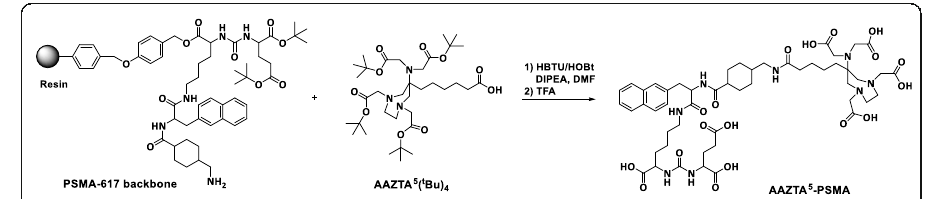
Fig. 2 Reaction of AAZTA 5 ( t Bu 4 ) with PSMA-617 on resin via amide coupling forming AAZTA 5 -PSMA. AAZTA 5 ( t Bu 4 ) was synthesized according (Sinnes et al. 2019) and PSMA-617 following (Bene š ová et al.